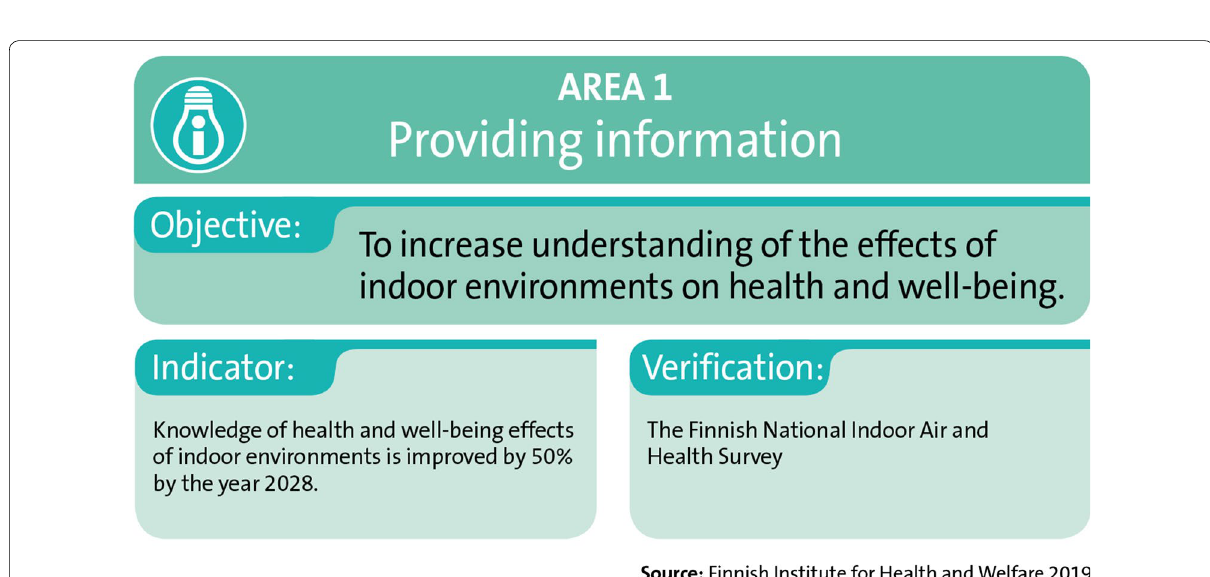
Fig. 6 The objectives, indicators, and verification sources for area